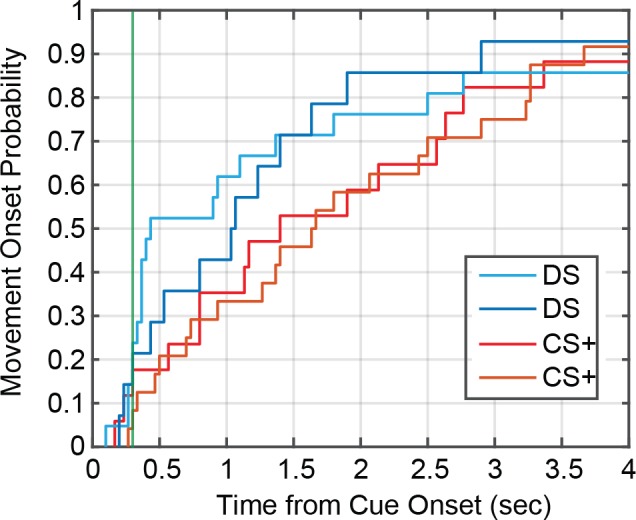
Movement onsetdistributions.Cumulative distribution plot showing movement onset distributions from two rats trained under an instrumental contingency (DS, dark and light blue) and two rats trained under a Pavlovian contingency (CS+, red and orange). The green line indicates the end of the post-cue period used for neural analysis (300 ms).